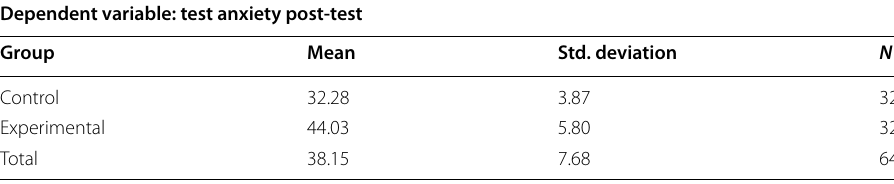
Table 7 Test anxiety descriptive statistics